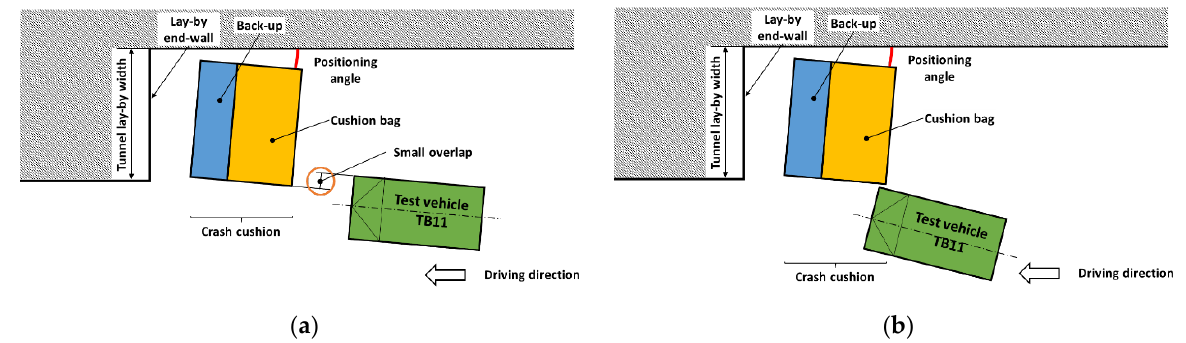
Figure 13. Crash configurations for crash cushion. ( a ): Small overlap of the vehicle; ( b ): Impact into the transition of the cushion bag to the concrete back-up.